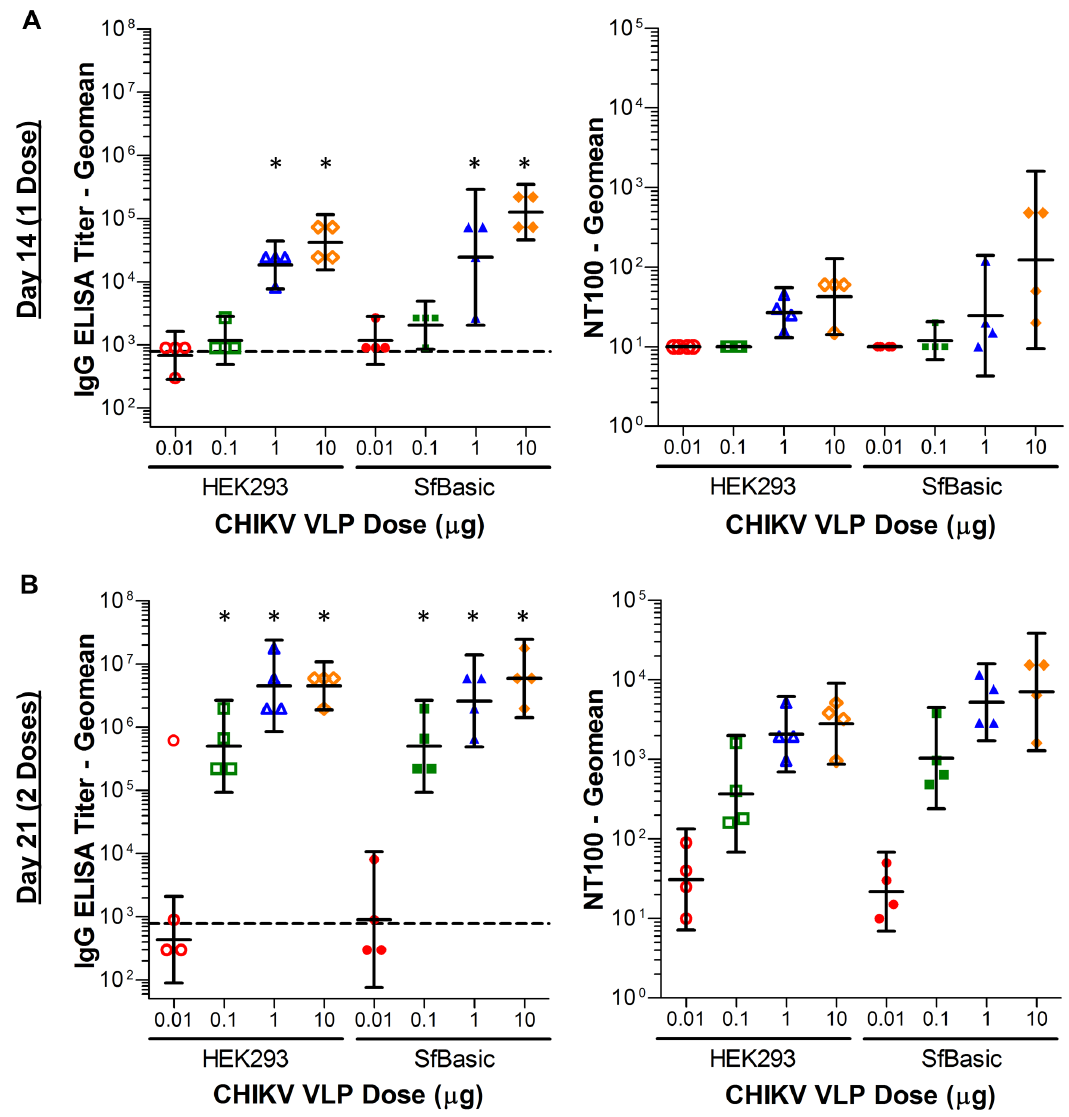
Figure 7. Immunogenicity assay titers from guinea pig sera after vaccination with adjuvanted Sf Basic-derived and HEK293-derived CHIKV VLPs. ( A ) Anti-CHIKV IgG geomean titer and CHIKV 181/25 geomean neutralizing titer (NT100) at study day 14 (14 days after first dose). ( B ) Anti-CHIKV IgG geomean titer and CHIKV 181/25 geomean neutralizing titer (NT100) at study day 21 (7 days after second dose). Geomean IgG ELISA background from pre-vaccination sera is indicated by a dashed line. Error bars represent 95% confidence intervals (N=4 animals per group), and asterisks indicate a statistically significant increase in titer over background (p , 0.05).